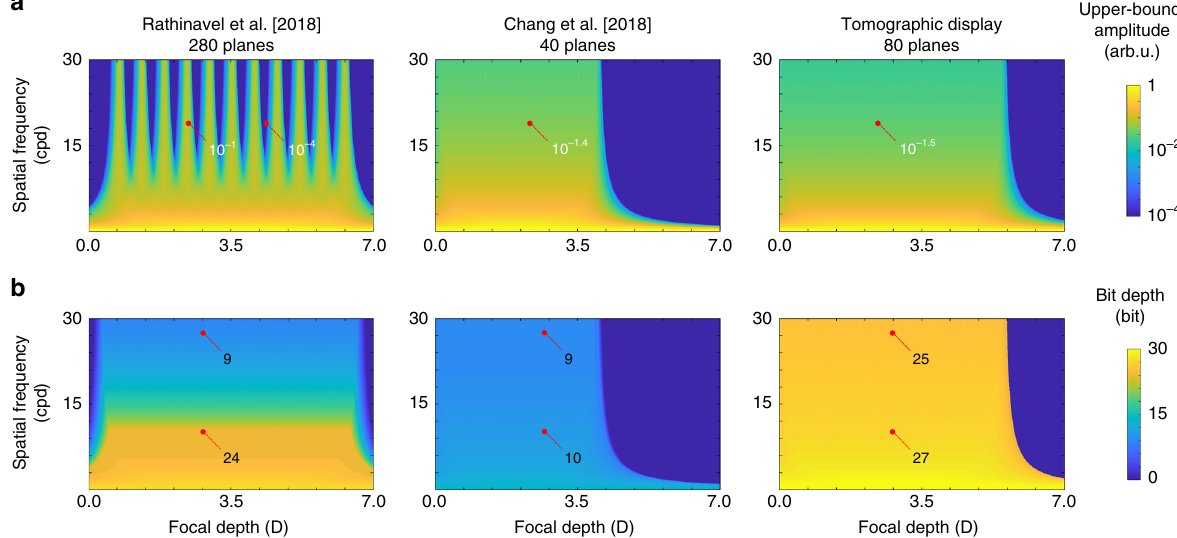
Fig. 4 Analysis of upper-bound amplitude and bit depth. a The upper-bound amplitude is the normalized Fourier coef fi cient of synthesized retinal images, and b the bit depth denotes the degree of freedom in the brightness modulation. Each criterion is plotted according to the spatial frequency of retinal images and the focal depth of observers. The simulation result compares the three prototypes of Rathinavel et al. 25 , Chang et al. 24 , and this work. Rathinavel et al. ’ s prototype 25 supports a limited depth of fi eld and bit depth at a high spatial frequency, and Chang et al. ’ s prototype 24 lacks the bit depth for a full color representation. On the other hand, tomographic displays show reliable performance, regardless of the spatial frequency and focal depth. The exact values at the red points are demonstrated for a precise comparison among those plane images are synthesized. We compared tomographic the synthesized images. The lower bound is considered as a displays with 80-plane displays to investigate the drawbacks constraint in the optimization. Second, we consider the offset generated from the slow frame rate of the display panel (60 Hz) in luminance to be a leakage of the backlight source caused by the tomographic displays. Contrary to tomographic displays, each multiple scattering of light through the backlight diffuser. When the offset luminance is not 0, each pixel of the focal plane is illuminated by a constant brightness, even if the corresponding backlight pixel is turned off. Third, the cost function for the optimization is derived in the frequency domain to re fl ect human visual characteristics. The most sensitive region for human vision visual metrics, including the peak signal-to-noise ratio (PSNR), is the spatial frequencies from 4 to 8 cpd 33 . Figure 6 illustrates two illumination strategies: primitive and optimal approaches. In the primitive strategy, each pixel is illuminated by the minimized time when its image is formed at using the display panel to increase the number of focal planes and the desired depth. On the other hand, the optimal strategy employs a speci fi c backlight operation that minimizes the cost function described above. If there is no offset luminance ( c ¼ 0) ¼ 0), the primitive and plane displays, where each focal plane is determined and a lower bound of brightness ( A low independently. optimal strategies are identical. When the lower bound of brightness is determined as A ¼ 0 : 625 m , the primitive solution is to illuminate the pixel around the desired depth. However, the optimal solution has several lobes for the backlight operation to exploit higher-order intensity distribution. When the offset